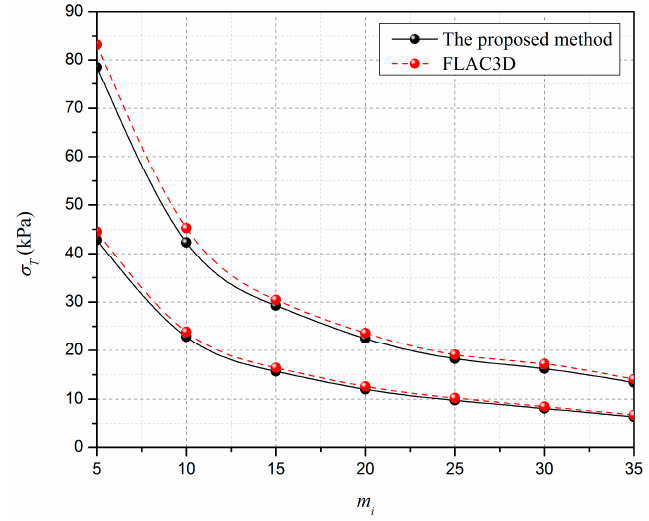
Figure 7. Validation of the proposed method.